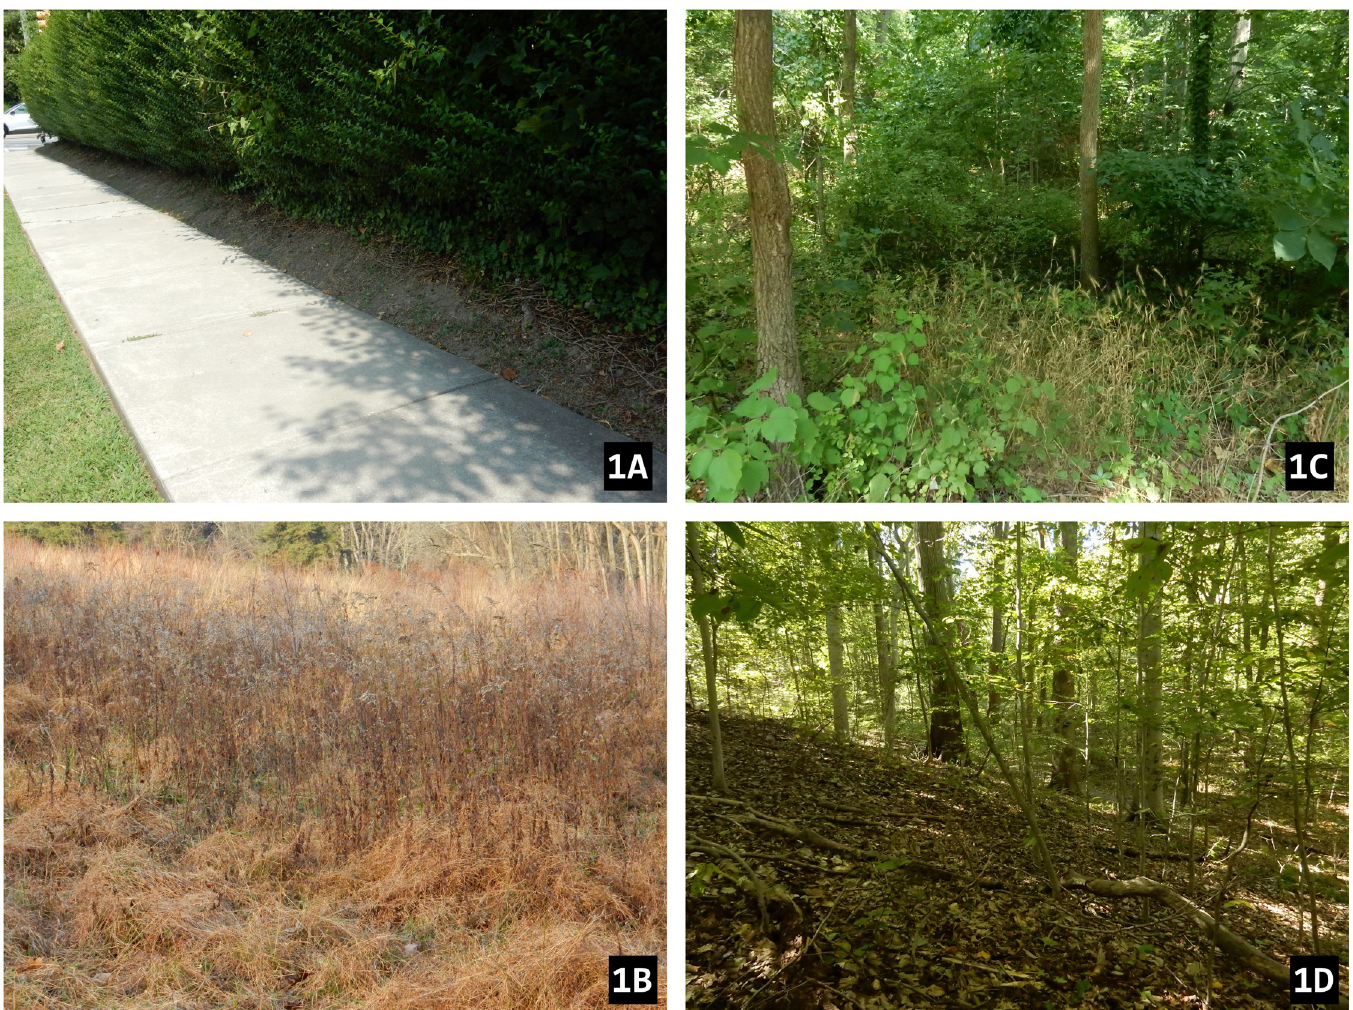
Fig 3. Habitats of A . karschi in Pennsylvania, USA; (1A) suburban bushes along Essex Ave (~200 m from type locality of A . snetsingeri ), (1B) fallow field at Tyler Arboretum, (1C) riparian woods, Swedish Cabin site on Darby Creek, (1D) forest, Smedley Park.